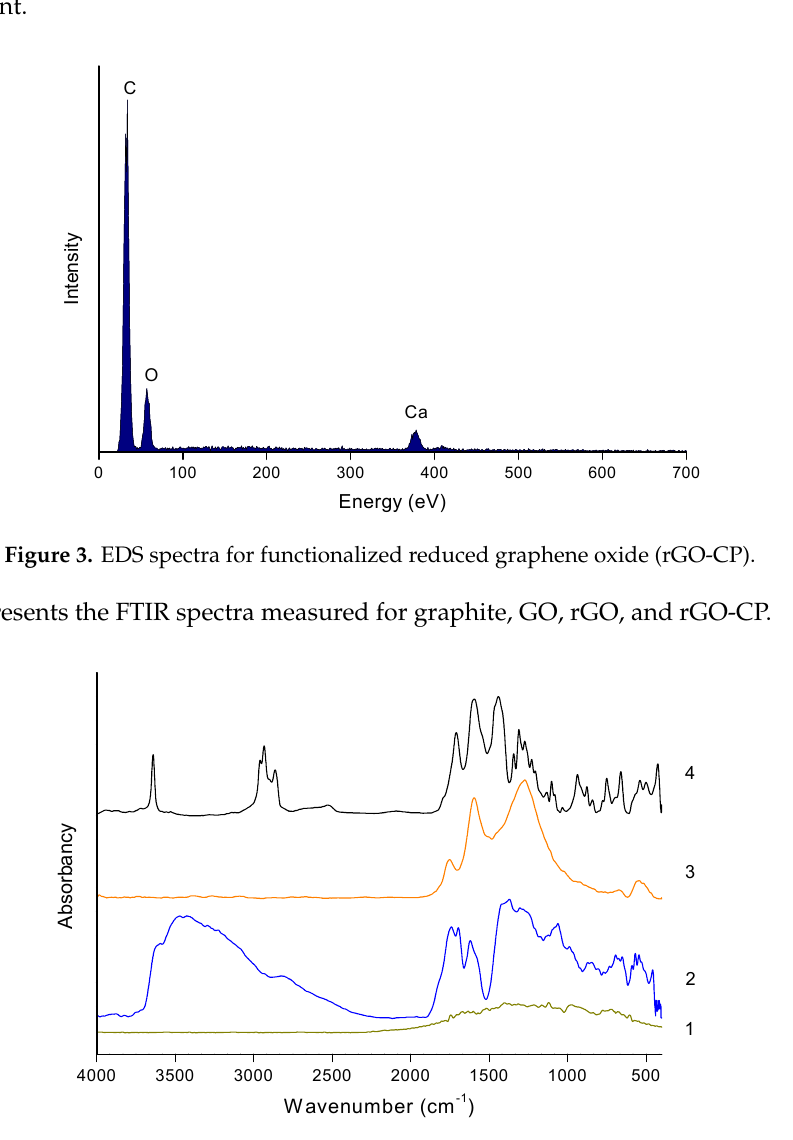
Figure 4. FTIR spectra of graphite (1), graphene oxide GO (2), reduced graphene oxide rGO (3), and reduced graphene oxide functionalized with calcium pimelate rGO-CP (4).